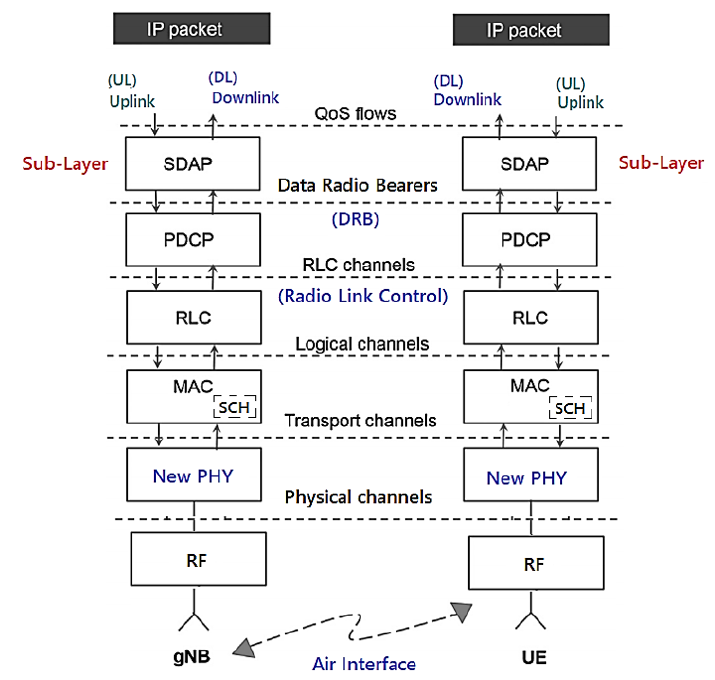
Figure 5. 5G NR/NGC SA protocol stack. Based on